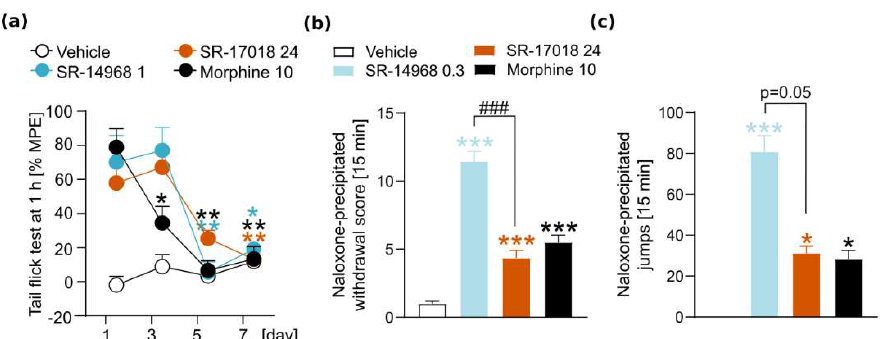
Figure 3. Effects of SR compounds on antinociceptive tolerance and physical dependence. ( a ) Repeated administration of SR-14968 (1 mg/kg, i.p.), SR-17018 (24 mg/kg, i.p.) and morphine (10 mg/kg, i.p.) resulted in the development of antinociceptive tolerance in the tail flick test. However, this effect developed slower in SR compound-treated groups. ( b ) Chronic treatment with all the drugs (SR-14968 at 0.3 mg/kg, SR-17018 at 24 mg/kg and morphine at 10 mg/kg, all drugs injected i.p.) resulted in withdrawal symptoms precipitated by naloxone (4 mg/kg, i.p.), measured as a global withdrawal score. Withdrawal score in SR-14968 group was significantly higher than in group treated with SR-17018. ( c ) In all of the groups, jumping behavior was enhanced. Data are presented as the mean ± SEM. Significant effects resulting from post hoc analysis are marked with * on the graphs: in ( a ) within-group effects significantly different from the first day of the experiment, in ( b ) and ( c ) effects compared to a vehicle group; differences between SR-agonists-treated groups marked with #. * p < 0.05, ** p < 0.01, ***/### p < 0.001. Numbers of animals: ( a ) vehicle n = 10; morphine n = 10; SR-1468 n = 9; SR-17018 n = 10, ( b – c) vehicle n = 10; morphine n = 10; SR-14968 n = 10; SR-17018 n = 9.